Question: Identify the chart type used in this figure.
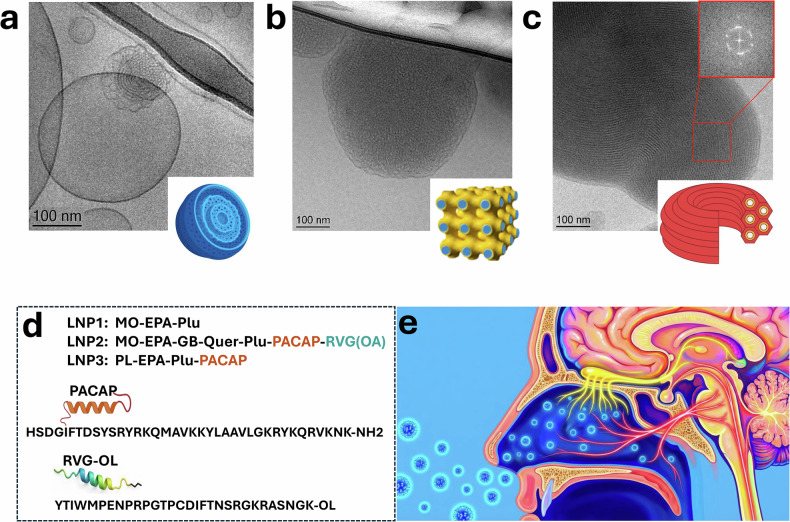
Answer: bar